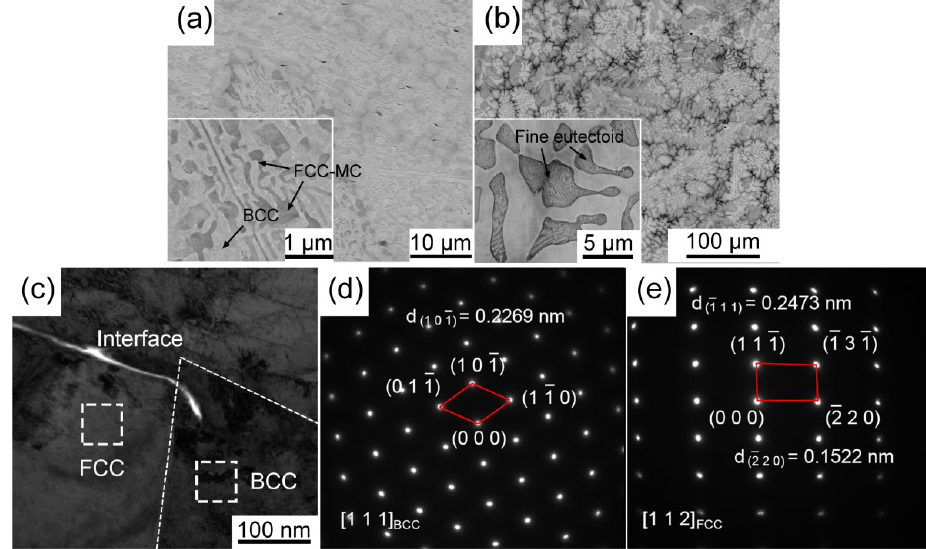
Figure 2. The ( a , b ) BSE images of W0.7 and W0.9 composites, respectively, and ( c ) bright-field TEM images of W0.7, ( d , e ) SAED patterns of BCC and FCC phase, respectively.